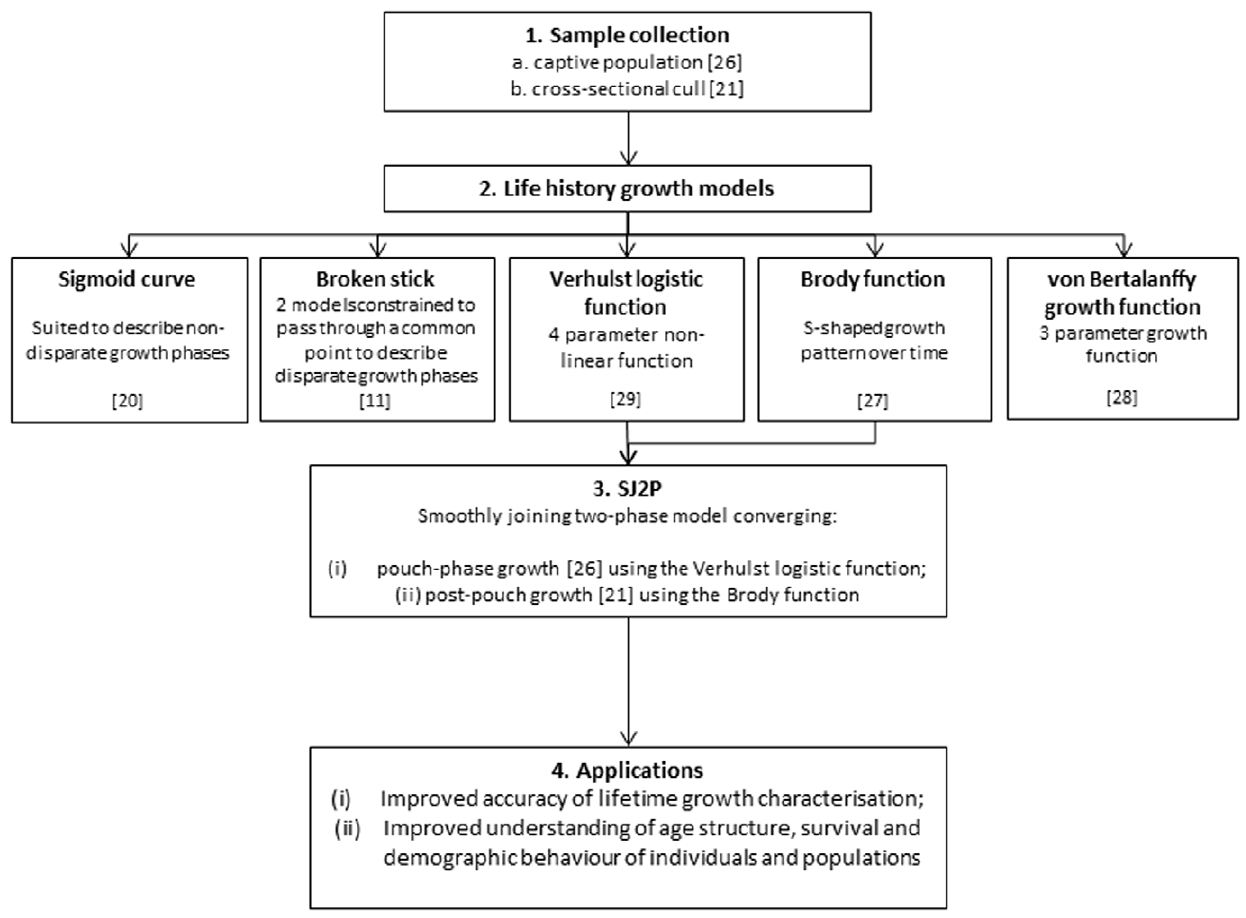
Figure 1. Overview of research aims, where (1) Sample collection involved head and foot (pes) measurements from (a.) a captive population of pouch-young pademelons [ 25 ] and (b.) a cross-sectional cull of a single cohort of pademelons [ 20 ] followed by (2) model selection for describing the life history growth of pademelons; followed by the development of (3) a smoothly joining two- phase (SJ2P) model; for (4) the improved accuracy of characterising and describing the lifetime growth of animals with disparate growth phases in order to enable an improved understanding of the age structure, survival and demographic behaviour of individuals and